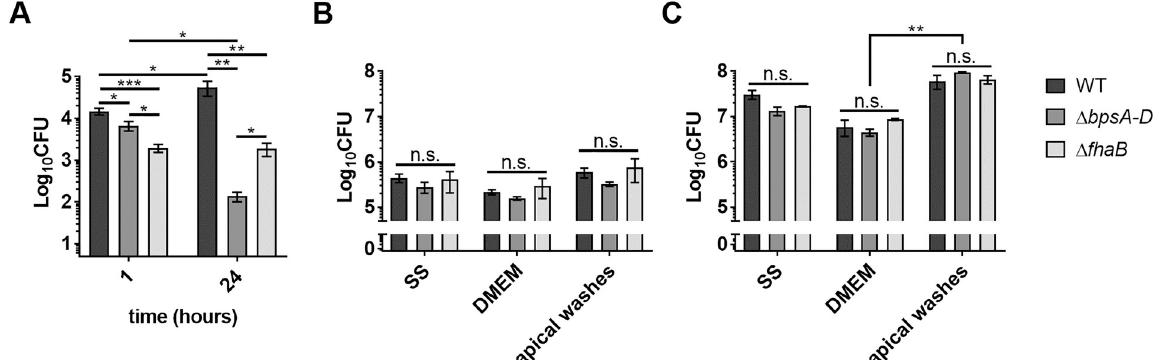
Fig 1. Bps and FHA promote infection of HBE cells. (A) CFUs of WT, Δ bpsA-D , and Δ fhaB strains after 1 and 24 h of infection. Mean values of four biological replicates in technical duplicate are presented with standard error of the mean. Statistical differences were assessed by two-way ANOVA. � , p < 0.05; �� , p < 0.005; ��� , p < 0.0005. (B and C) Bacterial strains were added to empty wells (without Transwells) of a 24-well plate in either SS, DMEM, or apical HBE washes. After 1 h (B) or 24 h (C), CFUs were enumerated on BG agar. Mean and standard error of the mean of three biological replicates in technical duplicate are presented. Statistical differences were assessed by two-way ANOVA. �� , p < 0.005; n.s., not significant.